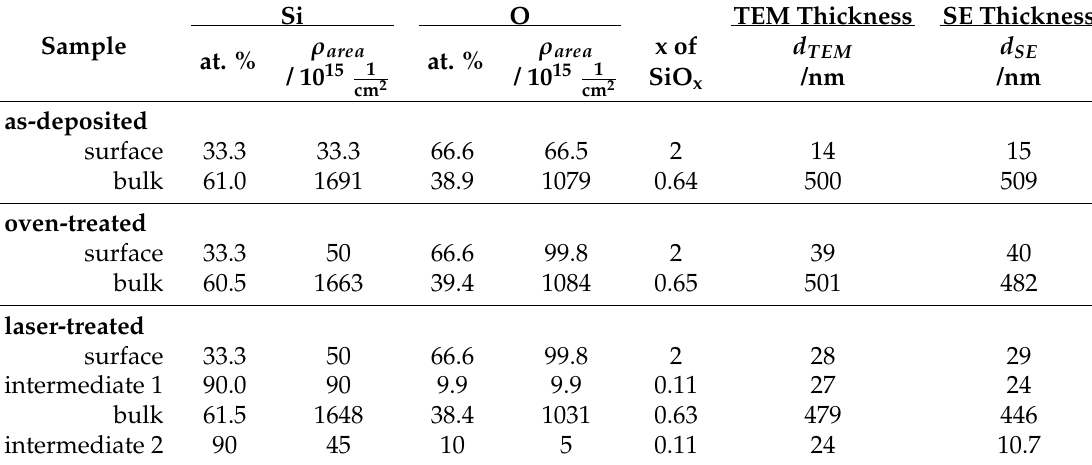
Table 1. Overview of RBS results of SiO 0.6 layers on SiO 2 , as-deposited, oven- and laser-treated. Atomic fraction (at. %), areal density ( ρ area ) of silicon and oxygen, the resulting x of SiO x fraction and thickness obtained by TEM, d TEM , as well as spectroscopic ellipsometry (SE), d SE , for individual layers